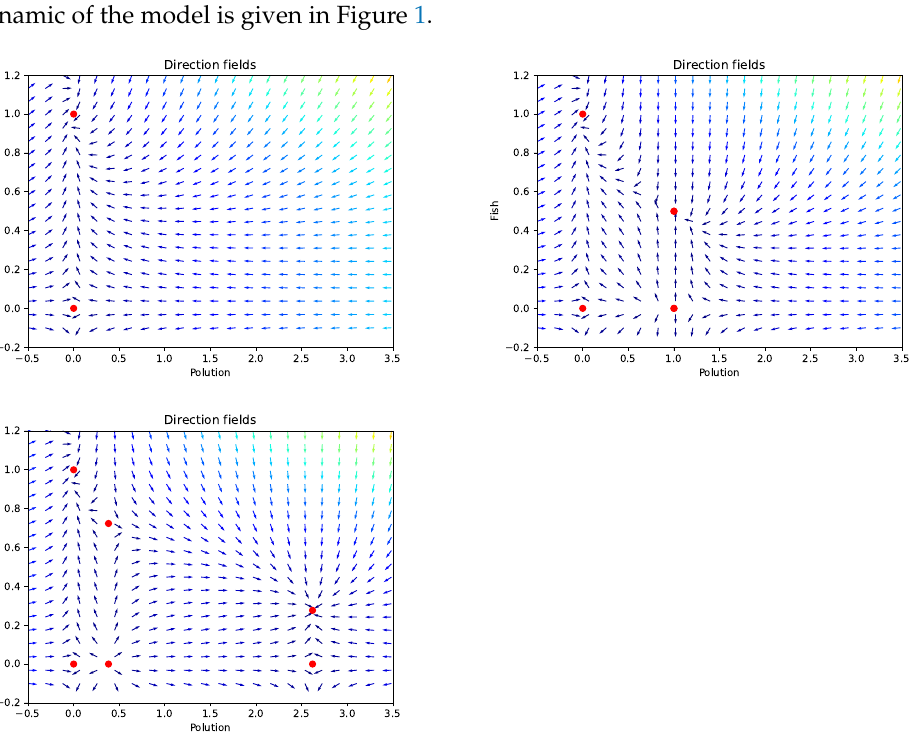
Figure 1. Phase field of the uncontrolled dynamics for R 0 ă 1 ( top left ), R 0 “ 1 ( right ) and R 0 ą 1 ( bottom left